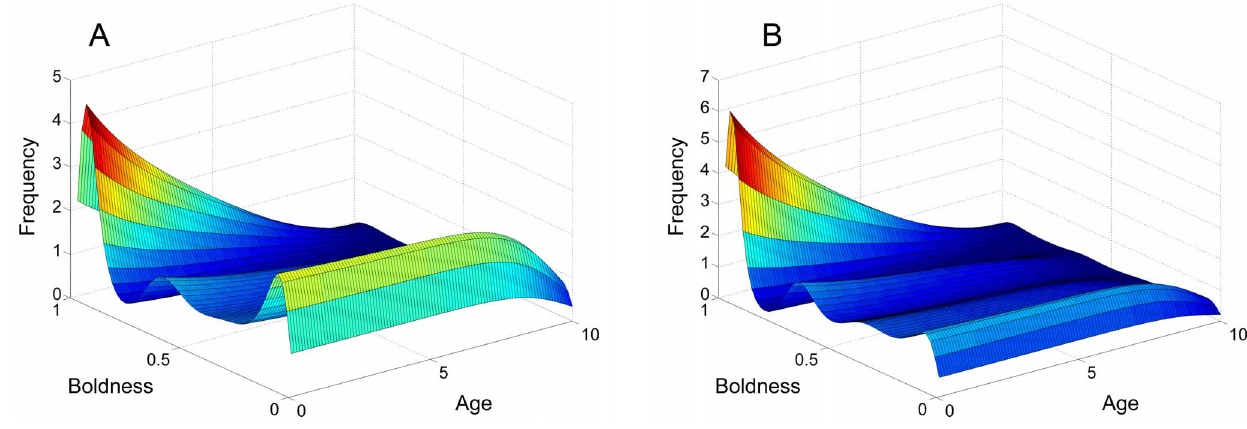
Figure 9. Solutions generated when competition is both skewed towards bold individuals and scaled according to boldness. Plots of u ( a , x , t ) at the equilibrium state, with the modified competition function Eq. (25). Panel A and B correspond to the case where a ~ 0 : 5 and a ~ 1 : 5 respectively.